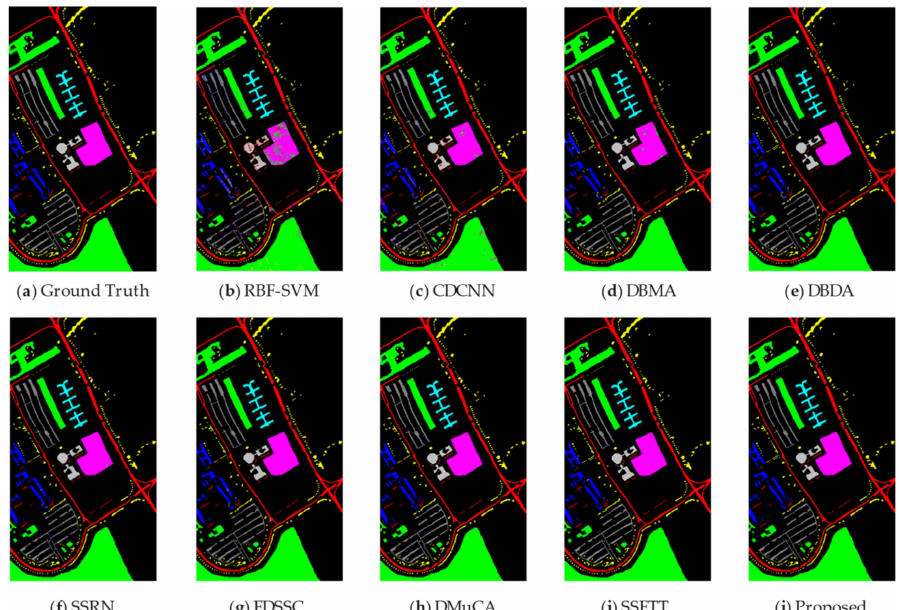
Figure 13. Classification maps of the Pavia University dataset with 5% training samples.